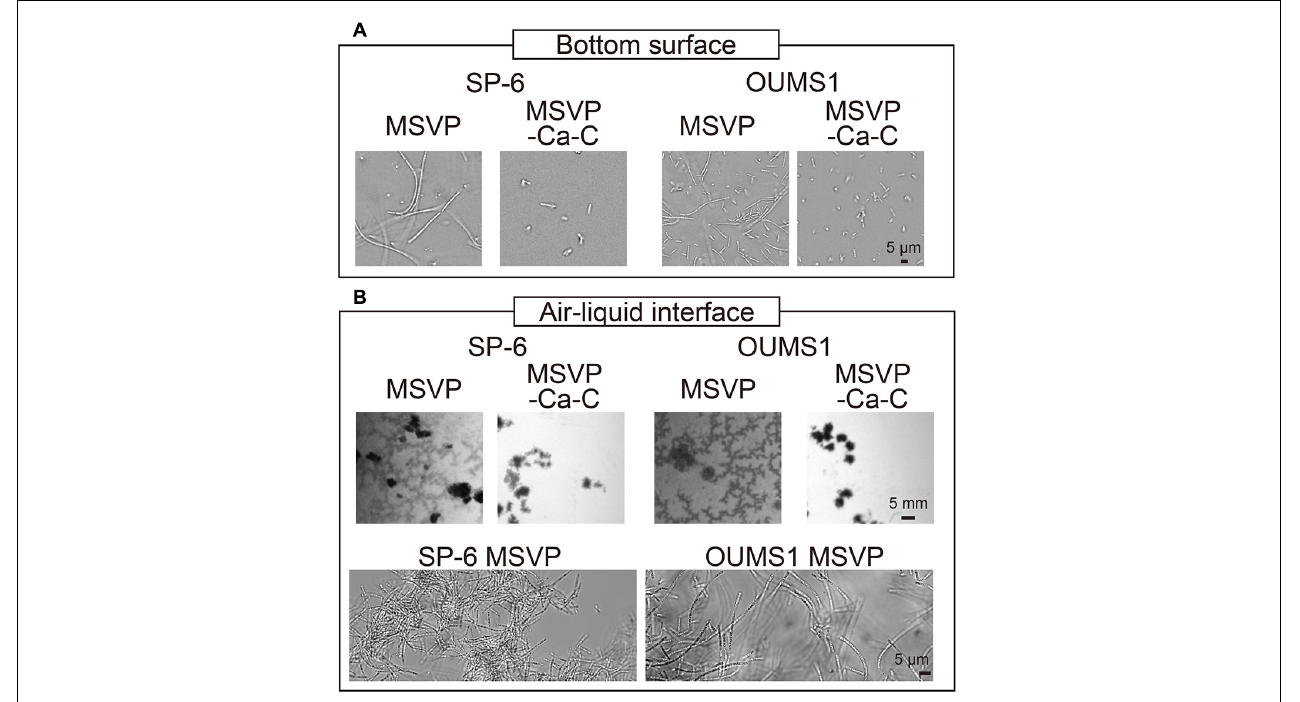
FIGURE 5 | Growth of SP-6 and OUMS1 cells in stationary liquid media. Images of SP-6 and OUMS1 cells after 24 h incubation and 12 h incubation, respectively, at the bottom of the dish (A) and the air-liquid interface (B) . The second set of micrographs in (B) are bright-field images of aggregates that were scooped out and imaged. Images of the cells taken in MSVP and MSVP-C-Ca are shown side by side for